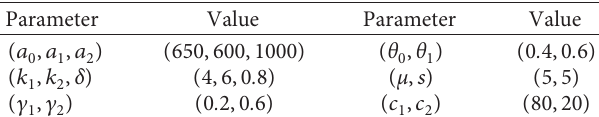
Table 2: Value of parameters.